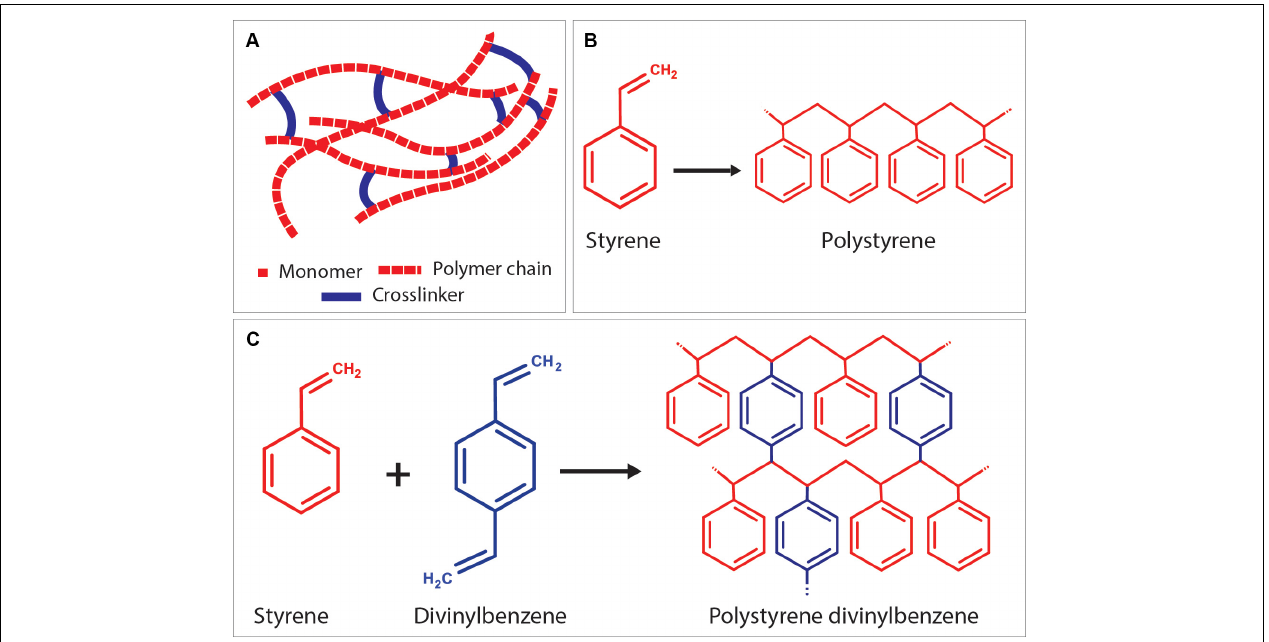
FIGURE 9 | (A) Positioning of the crosslinker between linear polymer chains. As an example; (B) formation of polystyrene chain from styrene monomers, and (C) crosslinking of polystyrene chains using the crosslinker,